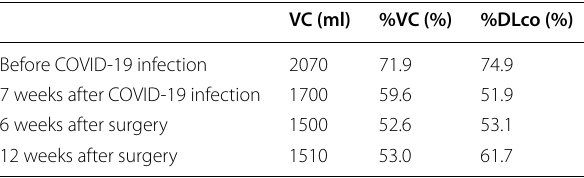
Table 1 Pulmonary function test results before and after COVID- 19 infection and 6 and 12 weeks after surgery